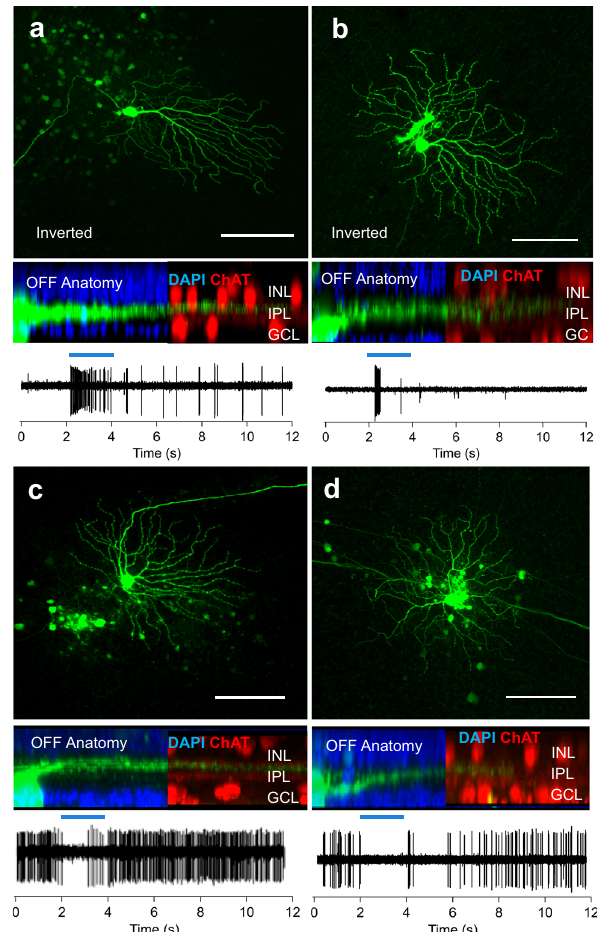
Fig. 5 Anatomy-function correlation of Mela(CTmGluR6)-triggered RGC responses in the treated rd1 retina determined by patch-clamp. Anatomy and corresponding light responses of 4 example RGCs from Mela(CTmGluR6)-treated rd1 retinas show that some native OFF RGCs ( a , b ) have inverted light responses (i.e., dendrites that stratify in the OFF sublamina of the inner plexiform layer (IPL) with a light response at the onset of light), while the light responses of other cells ( c , d ) are not inverted (i.e., cells that stratify in the OFF sublamina of the IPL respond at the end of the light stimulus). Also, see Supplementary Table 1. Light stimulus indicated as blue bar above spike trains (470 nm; 10 14 photons/ cm 2 /s). Scale bars = 100 µ